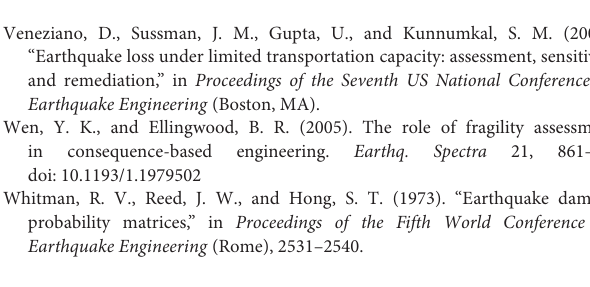
potential conflict of